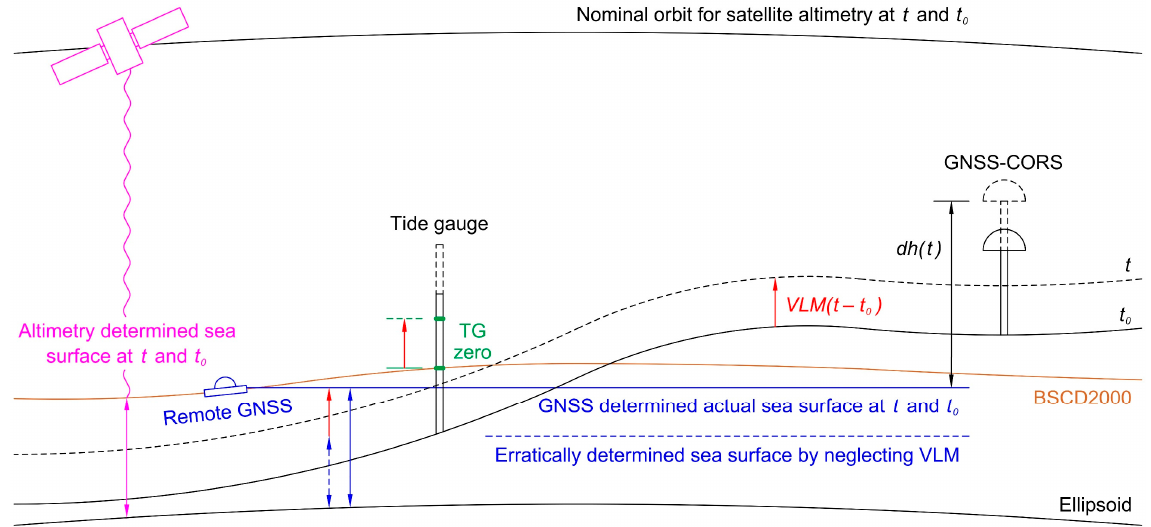
Figure 1. Simplified (assuming that DT and geoid change are negligible) interrelations between VLM ( VLM is the uplift rate, as depicted) affected reference surfaces and stations. The solid lines denote geometry at a reference epoch t 0 , whereas the dashed lines are geometry at a time of observation t . Note that BSCD2000 (brown line) coincides with the TG zero and geoid surface (also with sea surface heights in the figure since DT is assumed negligible). Notice that the figure depicts satellite altimetry unaffected by VLM, but in reality, altimetry records do contain GIA-induced geoid change (also refer to Sections 3 and 4).